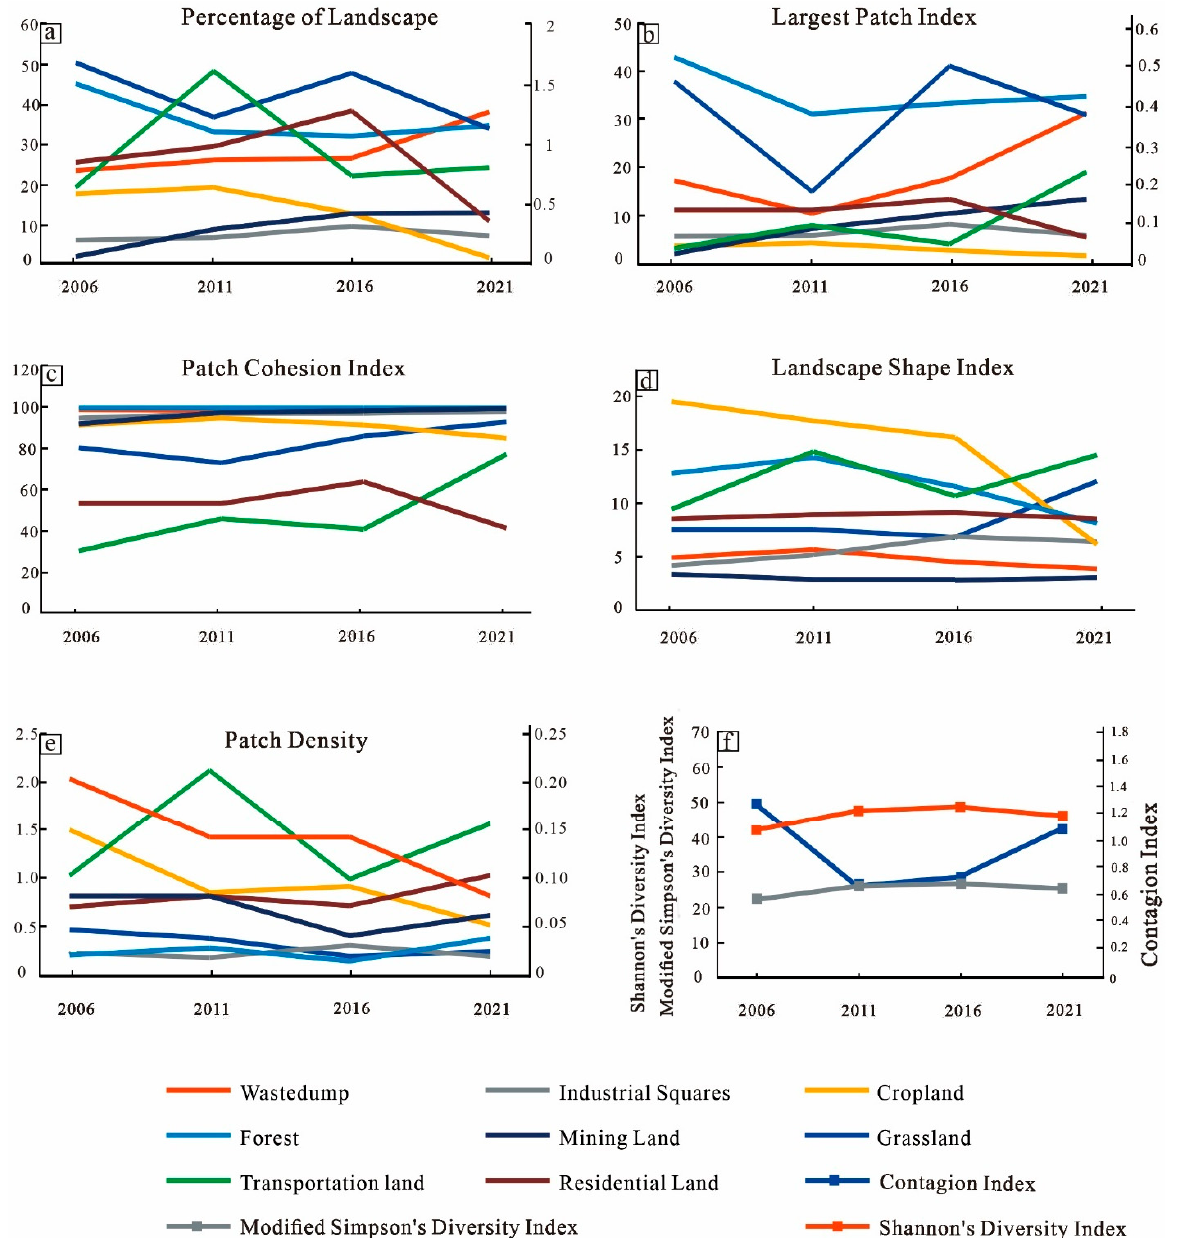
Figure 9. Characteristics of changes in landscape pattern index in the Heidaigou mining area. For class metrics: ( a ) The percentage of landscape (PLAND); ( b ) The largest patch index (LPI); ( c ) The patch cohesion index (COHESION); ( d ) The landscape shape index (LSI); ( e ) The patch density (PD). For landscape metrics: ( f ) The Shannon diversity index (SHDI), the contagion index (CONTAG), and the modified Simpson uniformity index